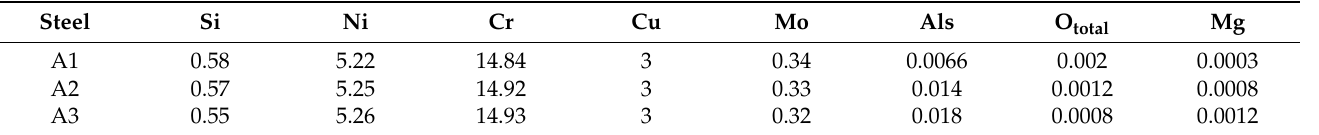
Table 4. Chemical makeup of the samples of slag following the interaction of slag with metal Table 2. Chemical composition of premelted slag (Mass percentage). (mass